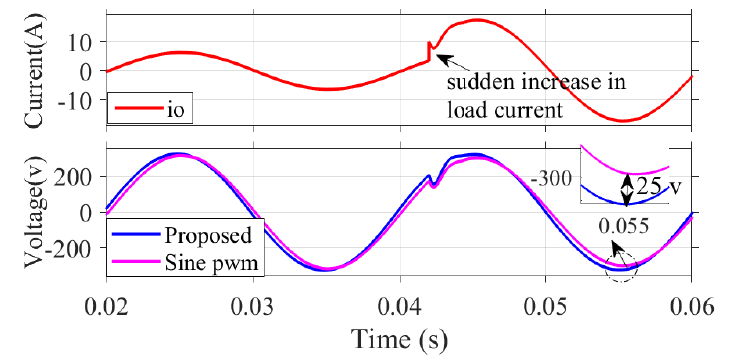
Figure 17. Variation of output voltage waveform for a sudden change in load current at t = 0.042 s.